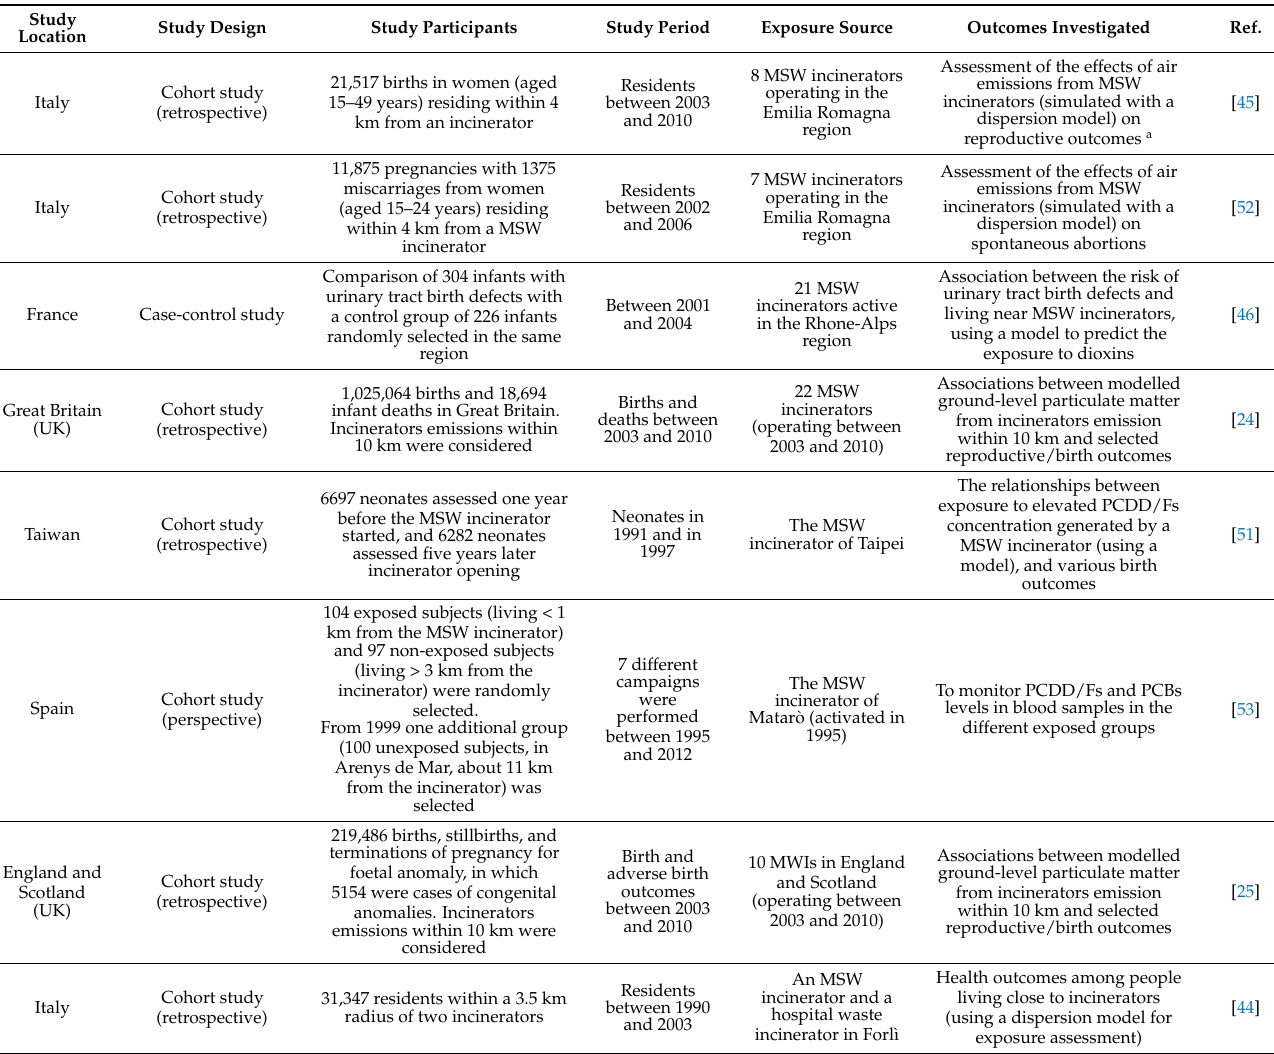
Table 3. Health outcomes associated with